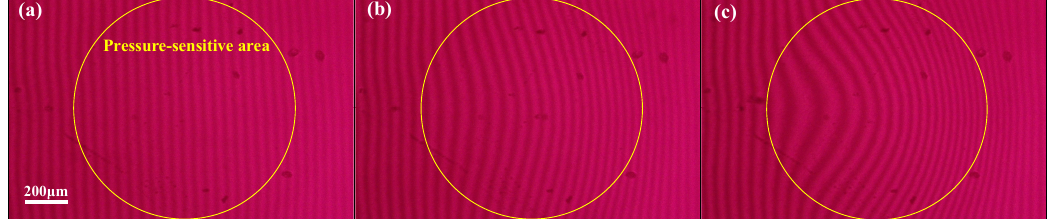
Figure 6. Images of interference patterns at pressure load of ( a ) 0 mmHg, ( b ) 22.5 mmHg, ( c ) 45 mmHg.